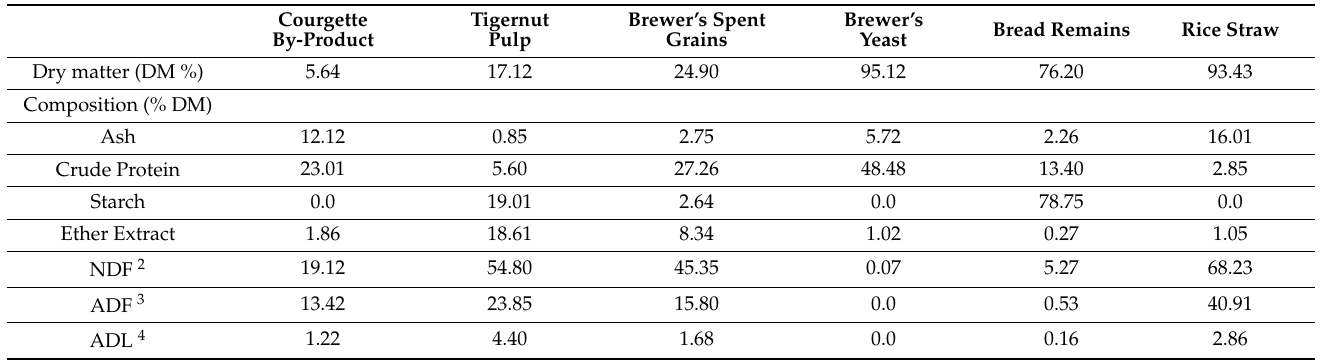
Table 1. Ingredients’ composition 1 of the byproducts used for diets for Tenebrio molitor